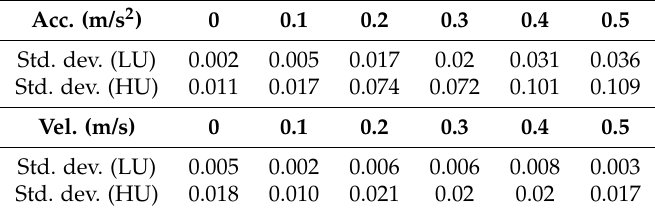
Table 2. Standard deviation of the control error with respect to the velocity and